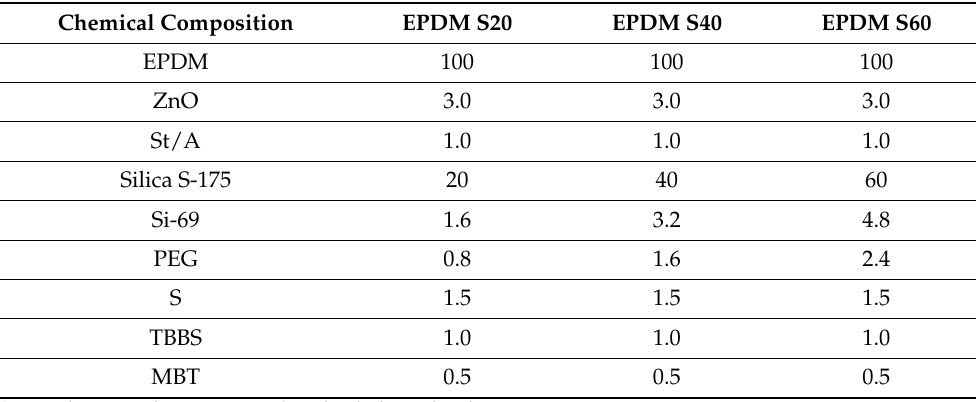
Table 2. Composition of the EPDM series with silica